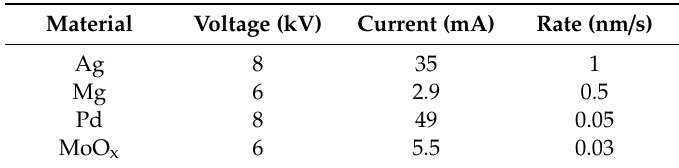
Table 3. Deposition parameters of electron beam